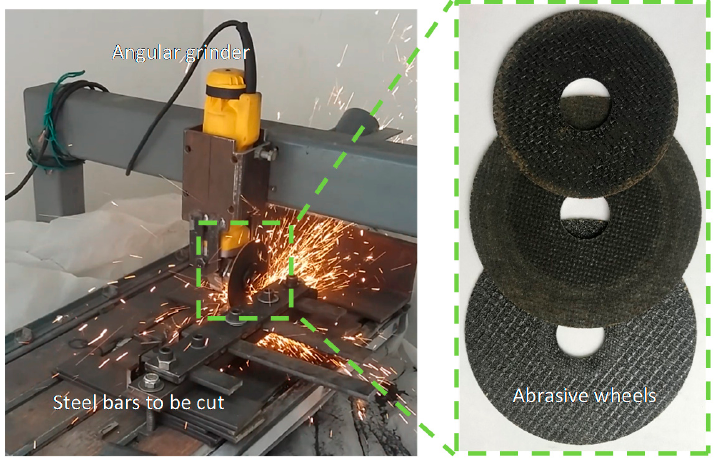
Figure 1. Set up used for experimental tests: manual grinder on a stiff bridge structure. Working table includes two movements, X and Y onto rectangular profile is clamped.